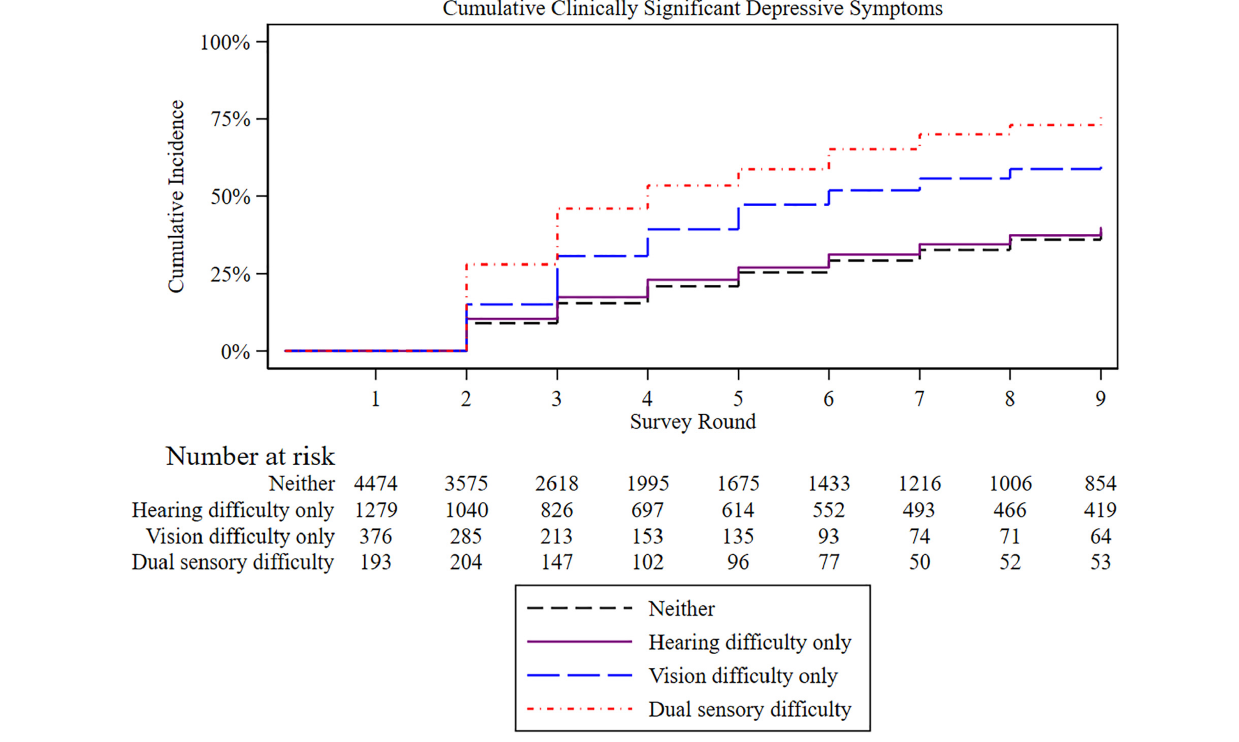
FIGURE 1 | Kaplan-Meier plot of incident cumulative clinically significant depressive symptoms by sensory difficulty. Those with baseline clinically significant depressive symptoms were excluded. Each survey round is separated by 1